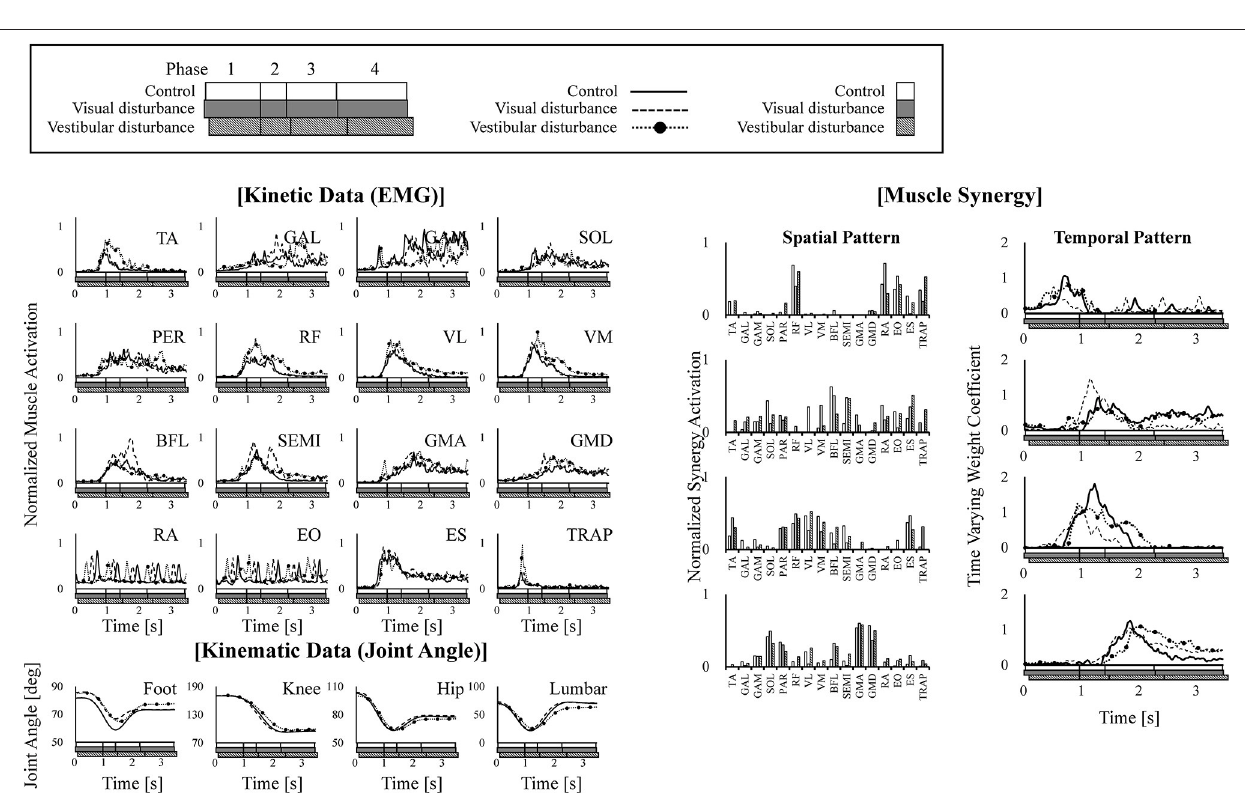
direction exceeded a defined threshold. Phase 2 was defined as the hip rise from a chair, and thus, its start time T 2 was calculated as the time when the hip reaction force became 0 N. In phase 3, the body leans forward the most and begins moving